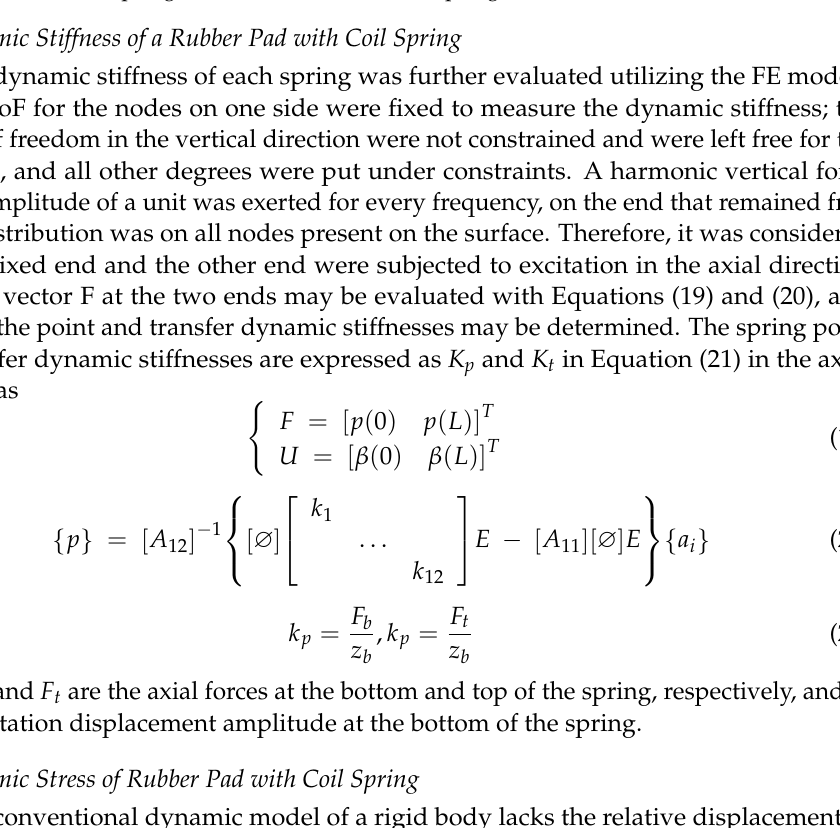
Figure 7. FE model of spring for ( a ) outer and ( b )